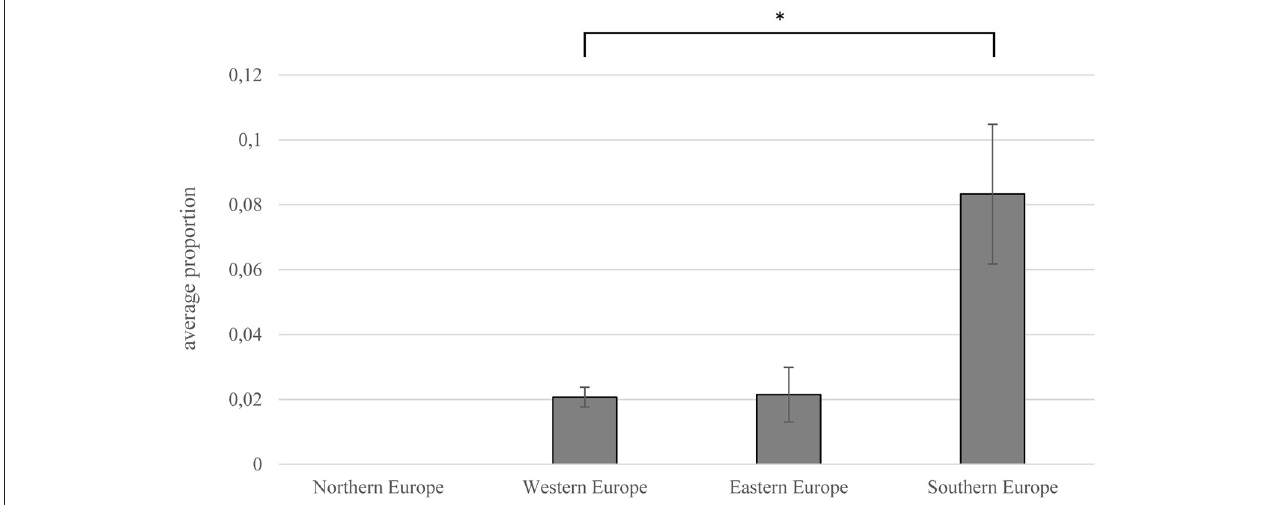
FIGURE 2 | Prevalence (ratio of C. burnetii -positive ticks to total number of tested ticks) depending on European regions. Error bars show average confidence interval; significance was proven using Mann–Whitney U-test (* p =